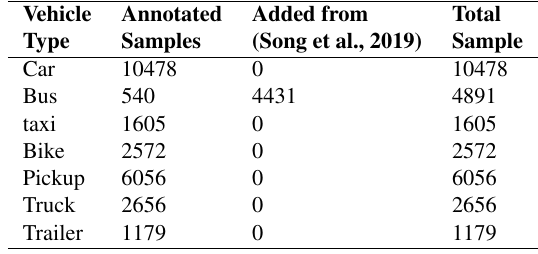
Table 1: The total number of samples collected to train the YOLOv5